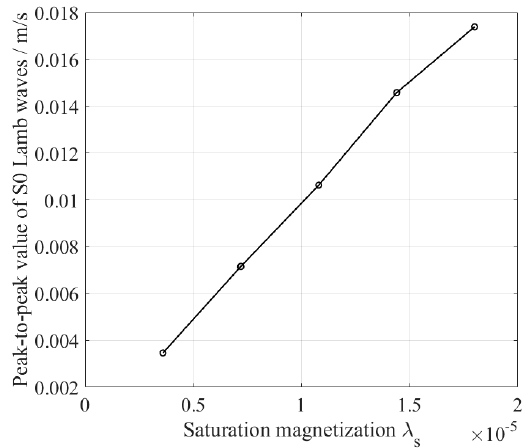
Figure 6. The relationship between the amplitude of S0 Lamb wave and the magnetostriction coefficient of the sample.